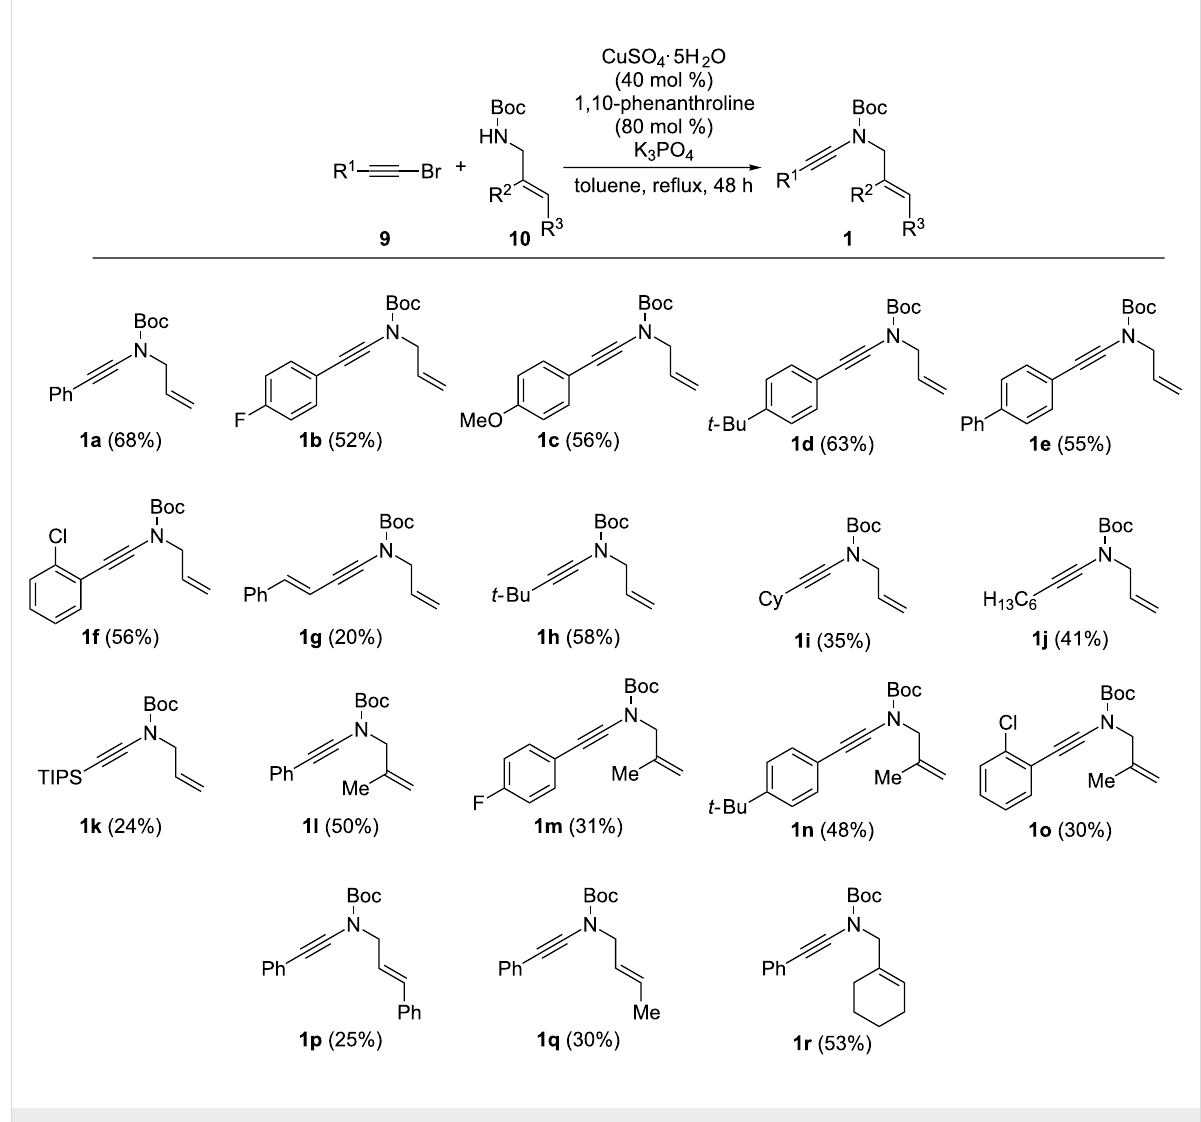
Scheme 3: Synthesis of the starting N